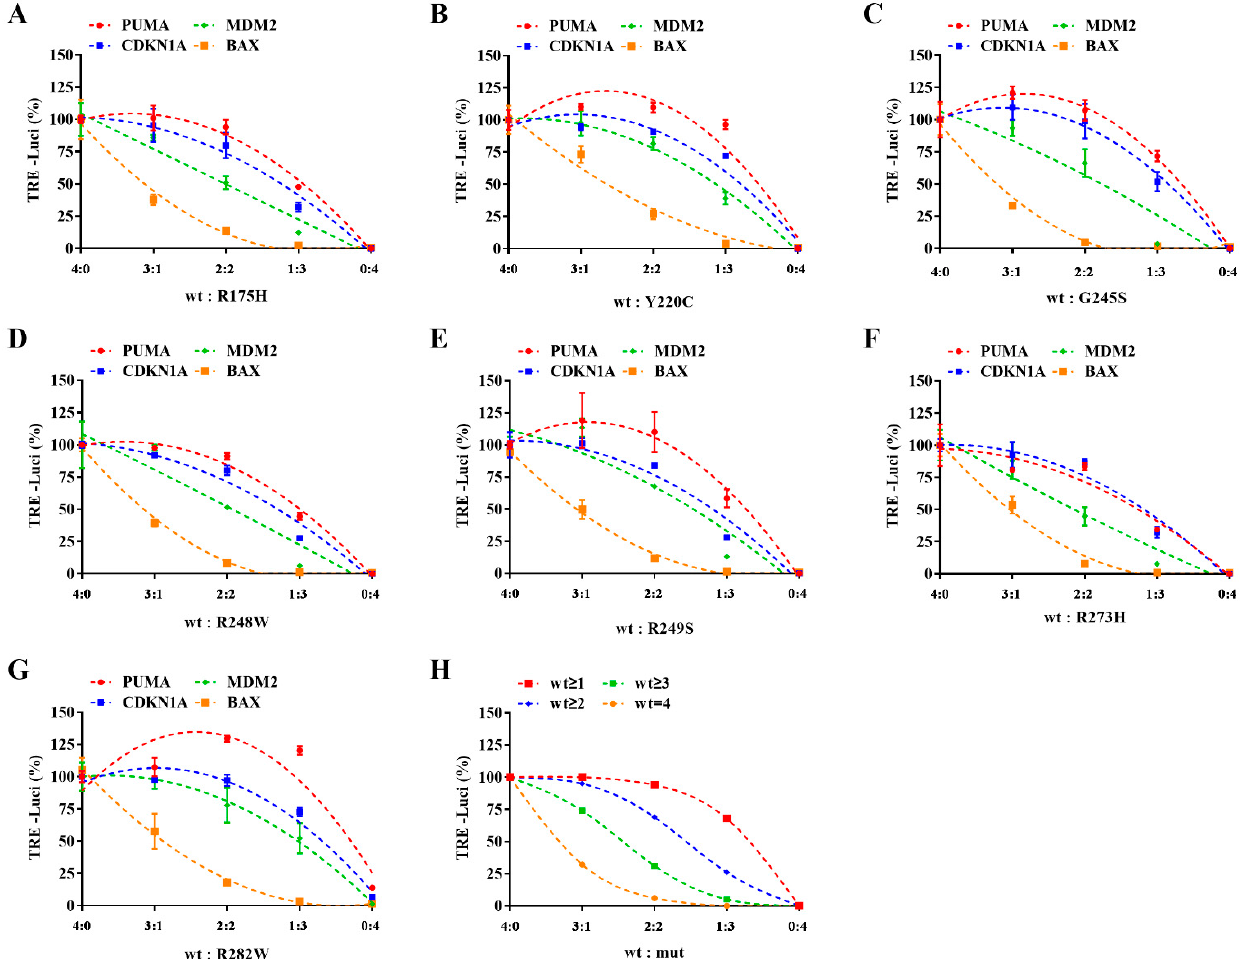
Figure 4. The response modes of the TRE of P53 target genes to DNE were observed by reporter gene assay and predicted by mathematical modeling. ( A – G ) The wtP53 and mutP53 expression plasmids were accurately pre-mixed according to the indicated proportion and transiently co-transfected with different reporter gene plasmids into NCIH1299 cells. After DOX treatment, the reaction of reporter genes to the mixed expression was observed and recorded ( n = 3). Data are presented as the mean ± S.D. obtained from three separate experiments. ( H ) Four TRE response modes were deduced from the given wt/mutP53 monomer proportion.